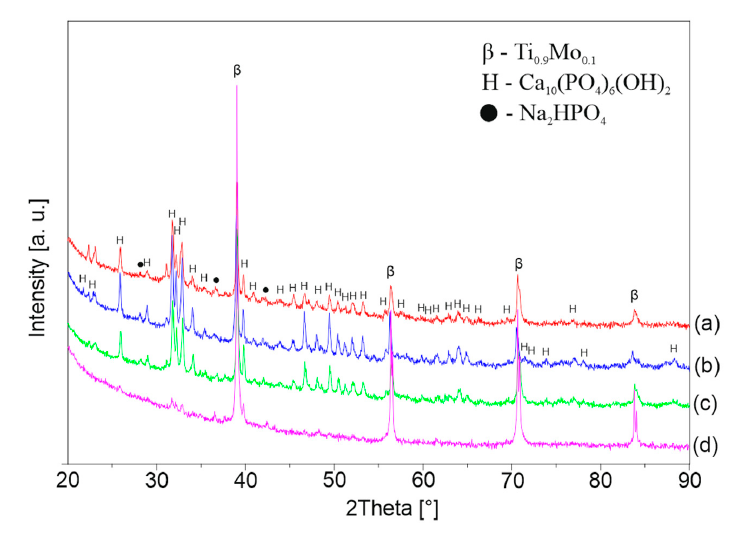
Figure 10. XRD patterns of ( a ) 23-5HT, ( b ) 23-7HT, ( c ) 23-10HT, ( d ) 23-12HT.